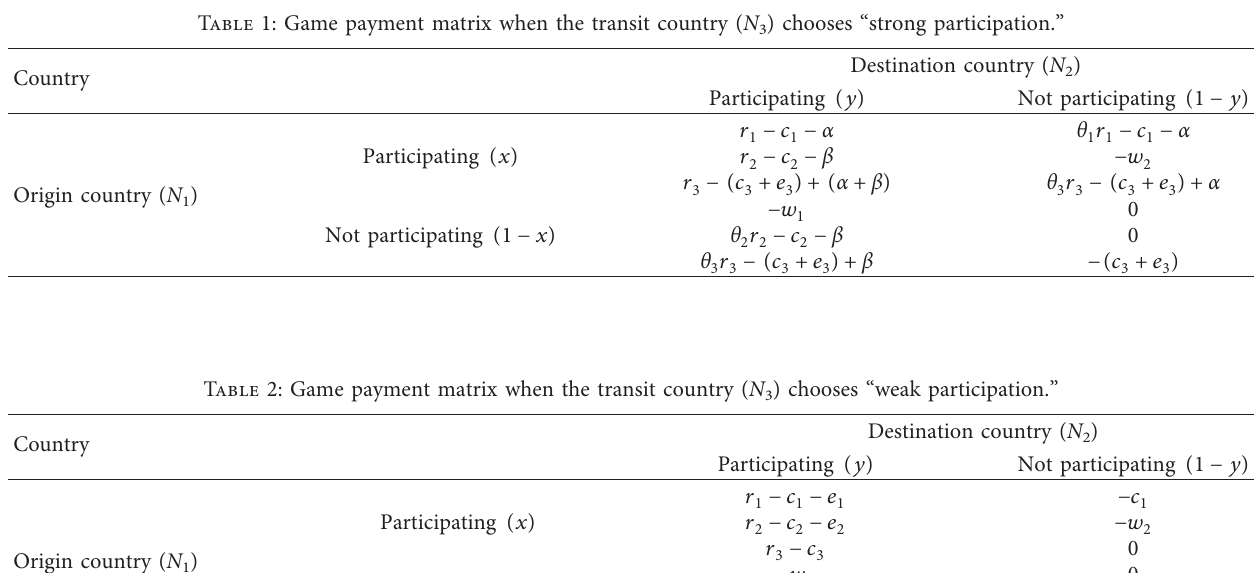
Table 1: Game payment matrix when the transit country ( N